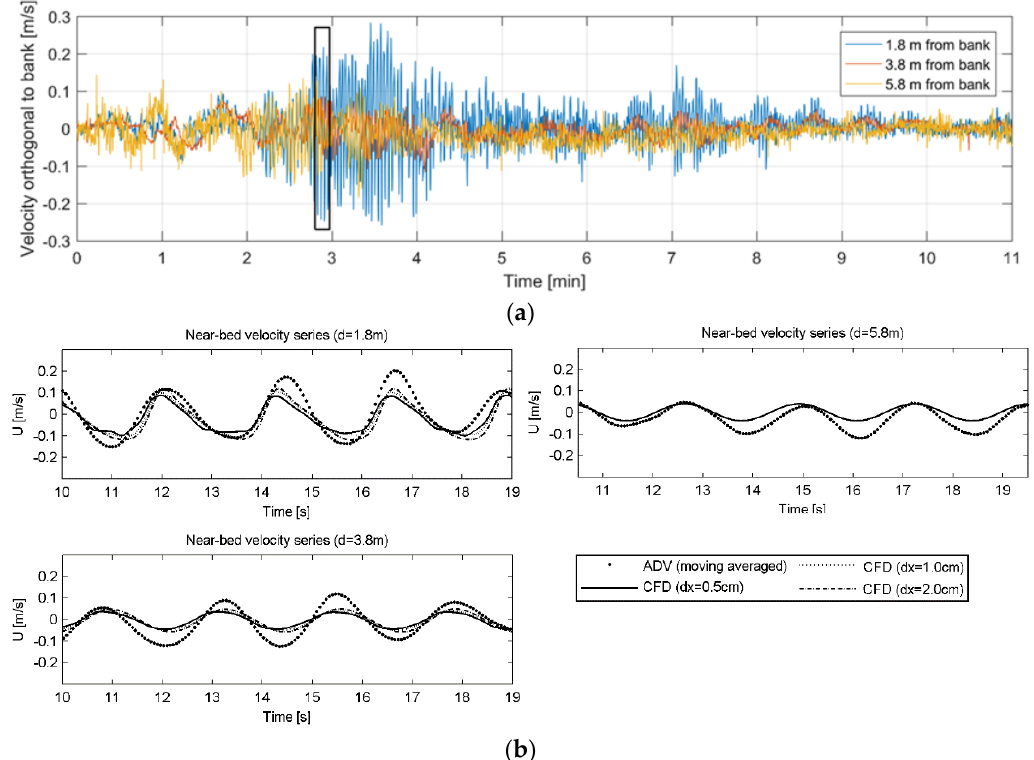
Figure 13. Measured near ‐ bed velocity time series at different distances from bank for the whole period ( a ); and modeled near ‐ bed velocity time series at three different grid resolutions ( b ).